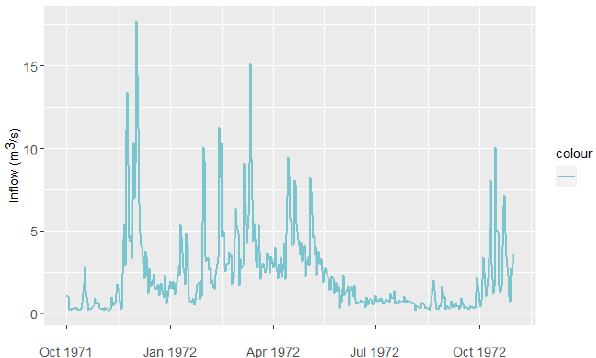
Figure 2. Streamflow time series at the intake for hydrological year 1971–1972.